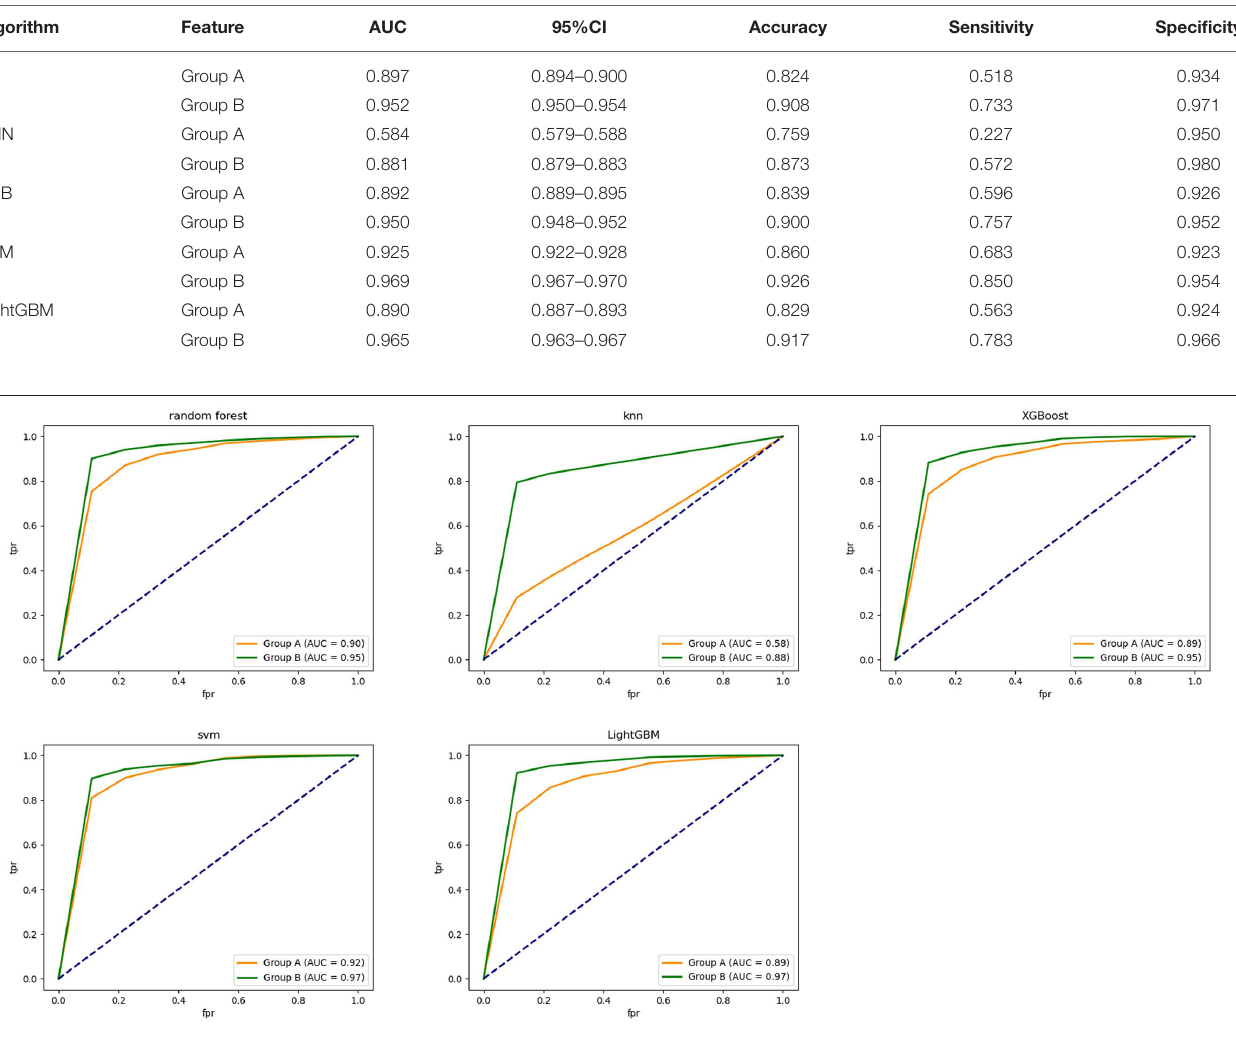
TABLE 1 | Performance of five algorithms with two feature groups.